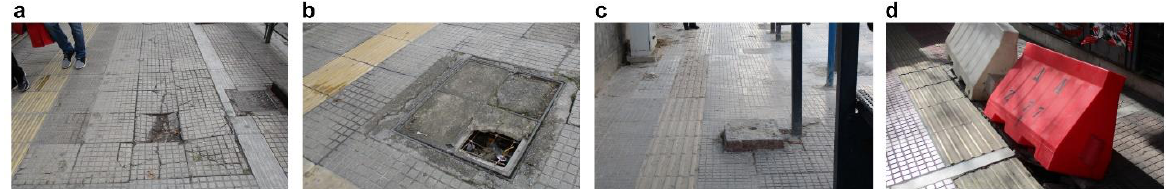
Figure 5. Examples ( a – d ) of uneven and dangerous parts of sidewalks with poor cleanliness and obstacles hindering walkability and increasing the risk of falling or tipping. Table 1. Key findings of our case study.